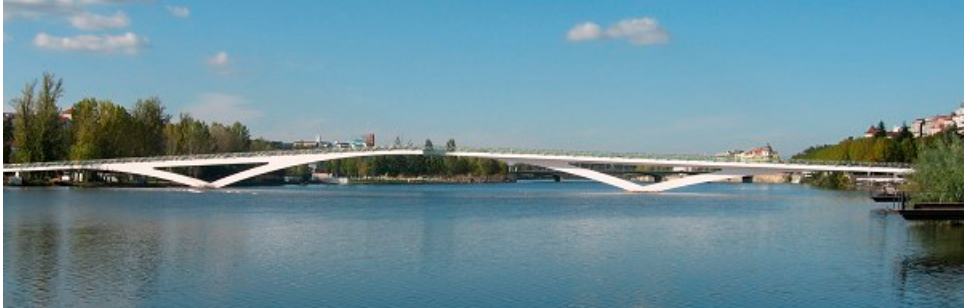
Figure 8. The Pedro e Inês footbridge. (Picture after https://structurae.net/en/structures/pedro-and- ines-bridge.).